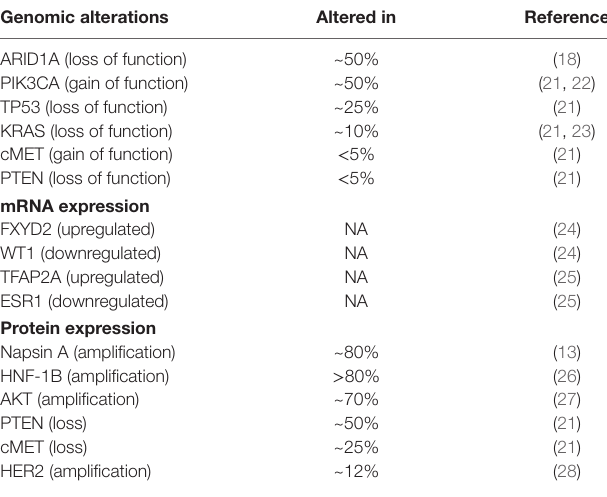
TaBle 1 | common alterations in ovarian clear cell